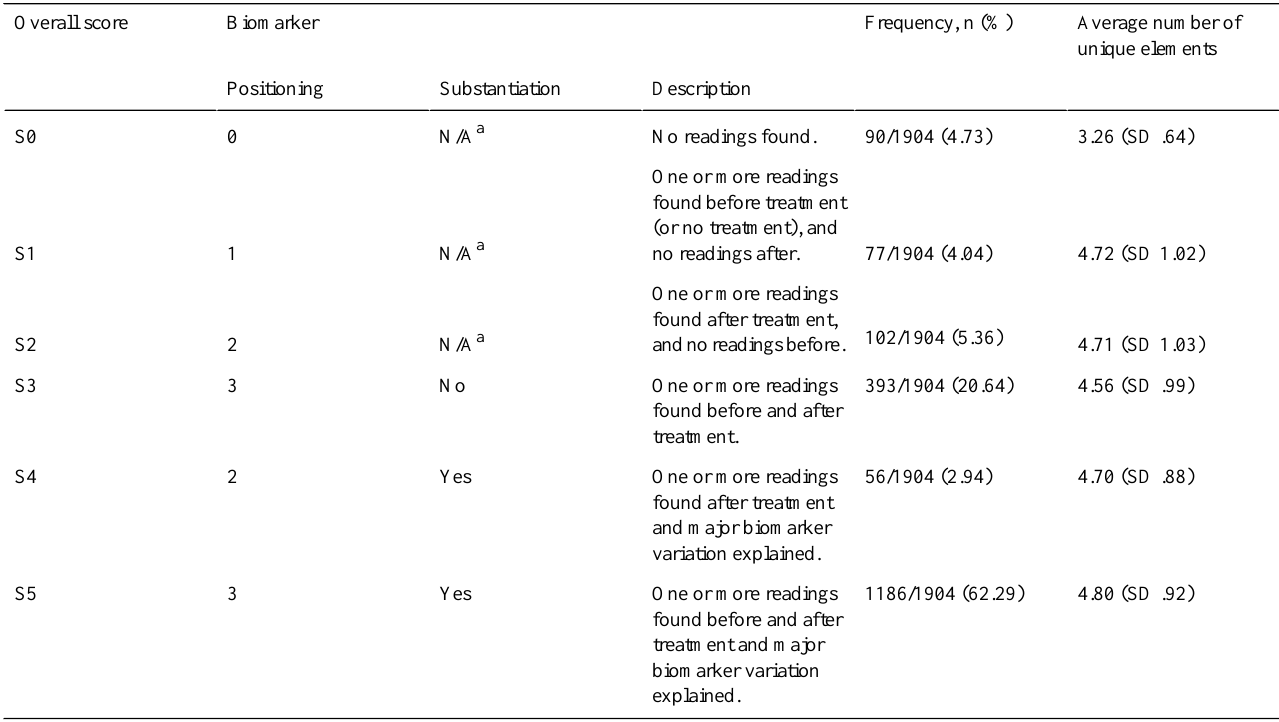
Table 4. Completeness scoring system for PSA trends in prostate cancer